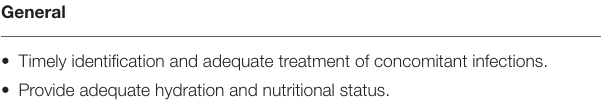
TABLE 2 | Special considerations for VTE prevention and management in children with IBD and IF.